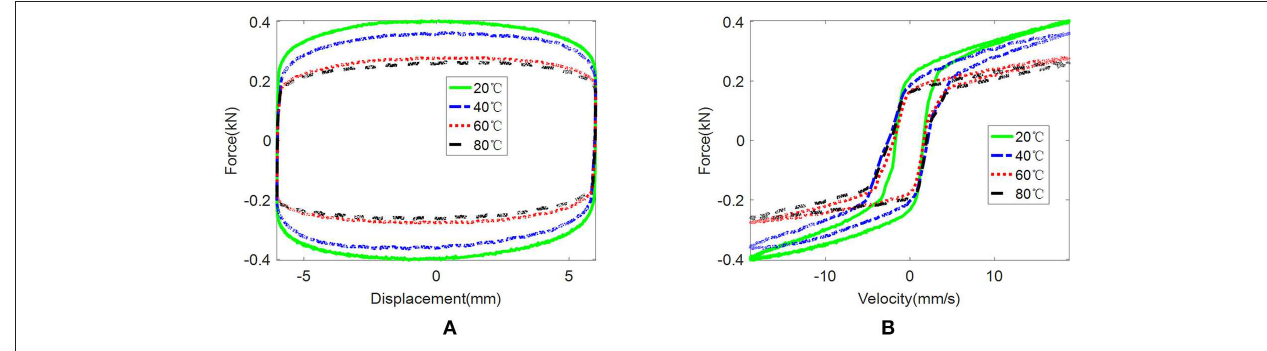
FIGURE 2 | Experimental results at an amplitude of 6mm, frequency of 0.5Hz and current of 1.2 A: (A) force vs. displacement and (B) force vs. velocity.